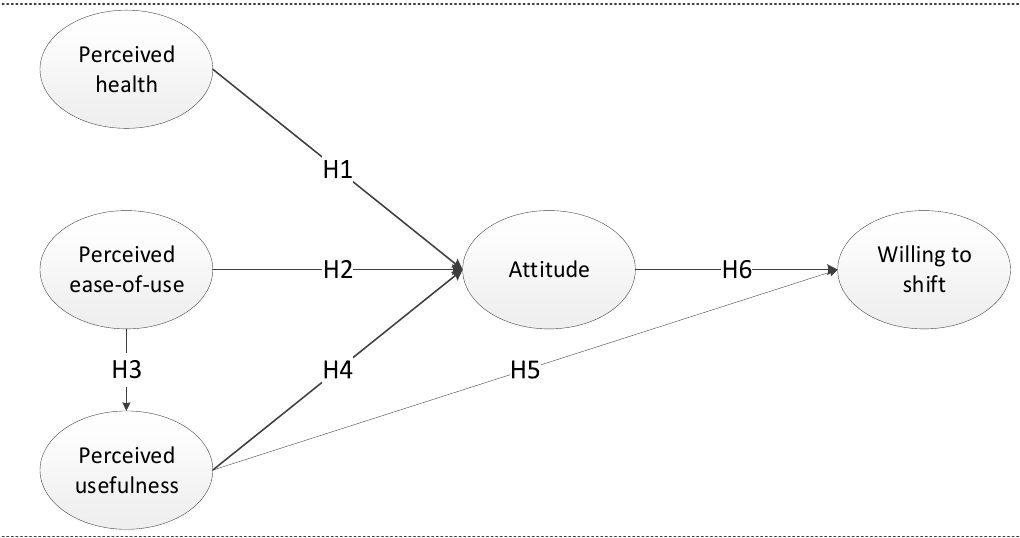
Figure 1. The theoretical framework of the modified technology acceptance model (TAM).